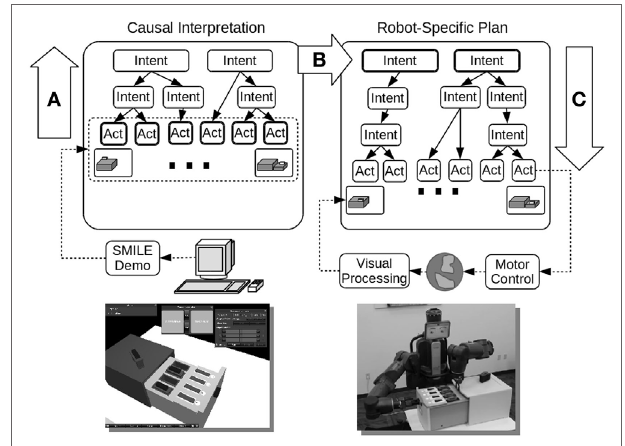
FigUre 1 | A top-level view of CERIL, the cognitive portion of our imitation learning robotic system. The abductive reasoning processes (infer the causes from the effects) are shown on the left: they produce a hierarchical causal network that represents at the top an explanation for the observed demonstrator’s actions. After learning, this explanation can be used to guide plan generation in related but modified situations, as illustrated on the right. Figure from Katz et al.